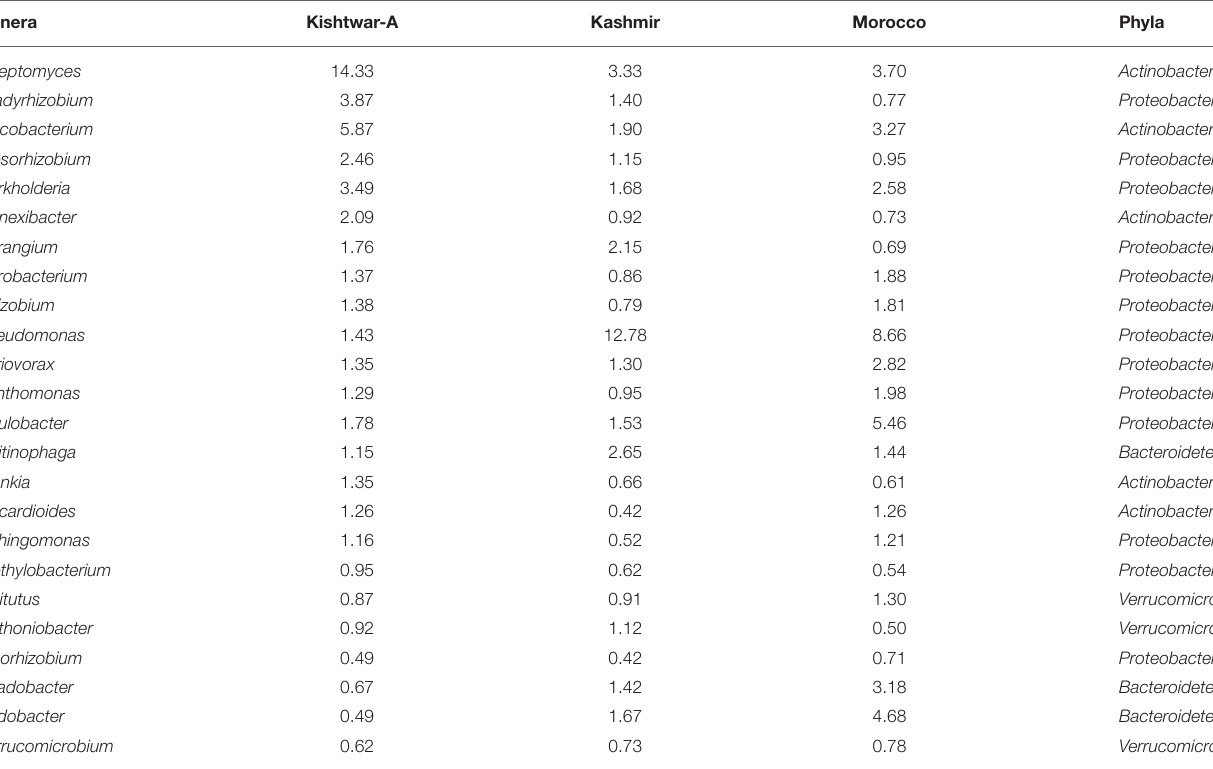
TABLE 4 | Core microbiome of three geographical regions (24 genera) (Kishtwar-A, Kashmir, and Morocco) with their relative abundance (%).